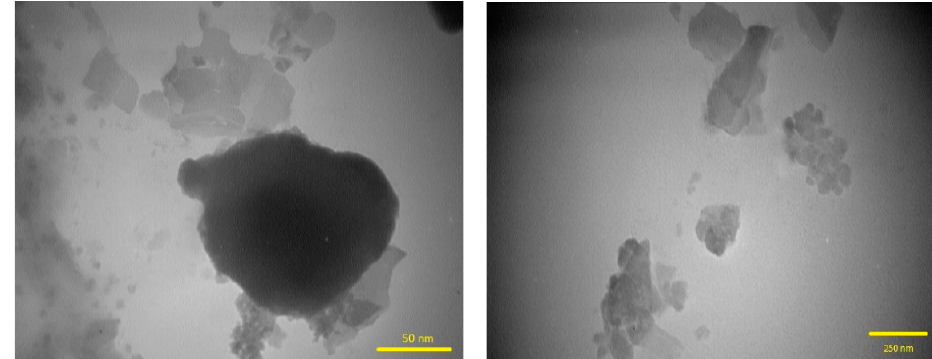
Figure 4. TGA curve of PCD-zeolite-IB.